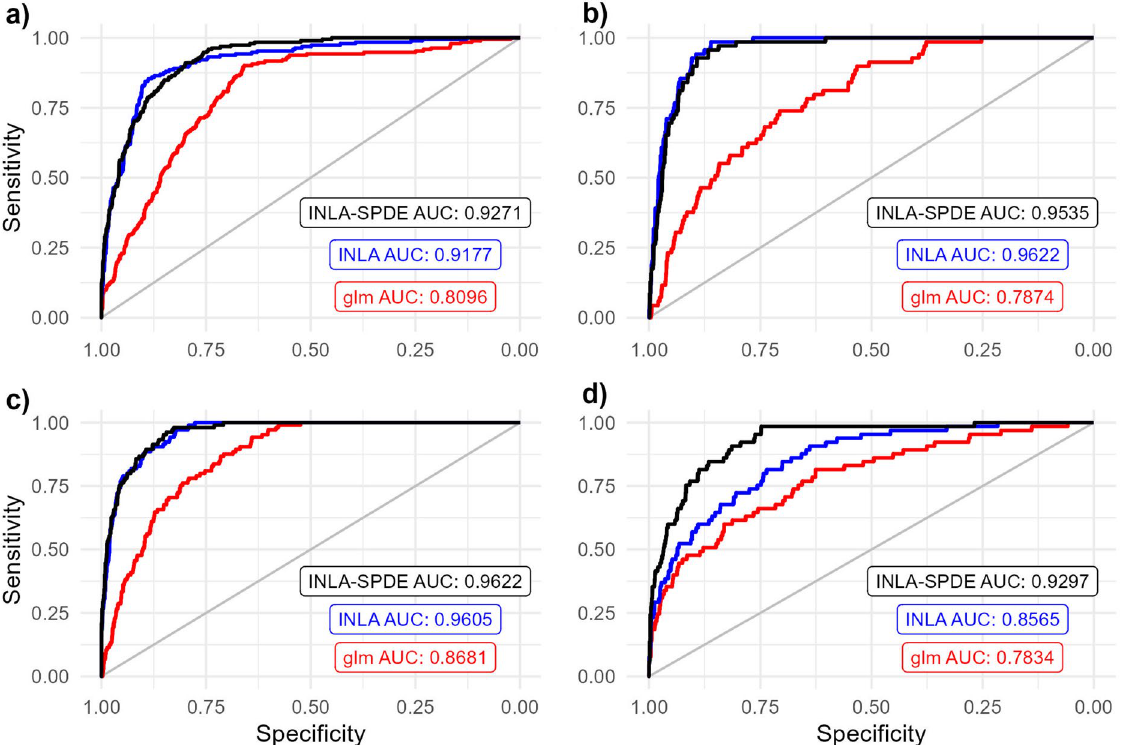
Figure 1. Receiver operator characteristic (ROC) curves and associated Area Under the Curve (AUC) values for the fitted glm models (red), fitted INLA models (blue) and fitted INLA-SPDE models (black) for ( a ) A. pectinata , ( b ) B. ewartiana , ( c ) D. fecundum , and ( d ) T. triandra